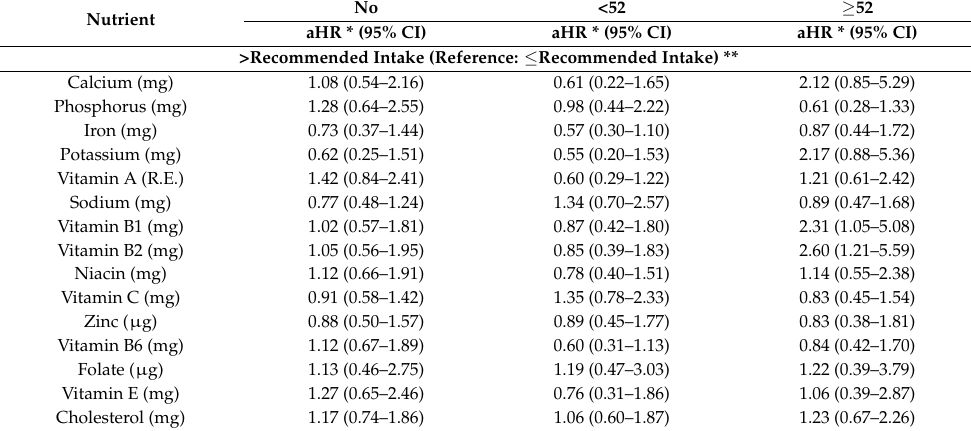
Table A2. Adjusted HR (95% CI) of breast cancer risk for the recommended nutrient intake level according to menopausal age.